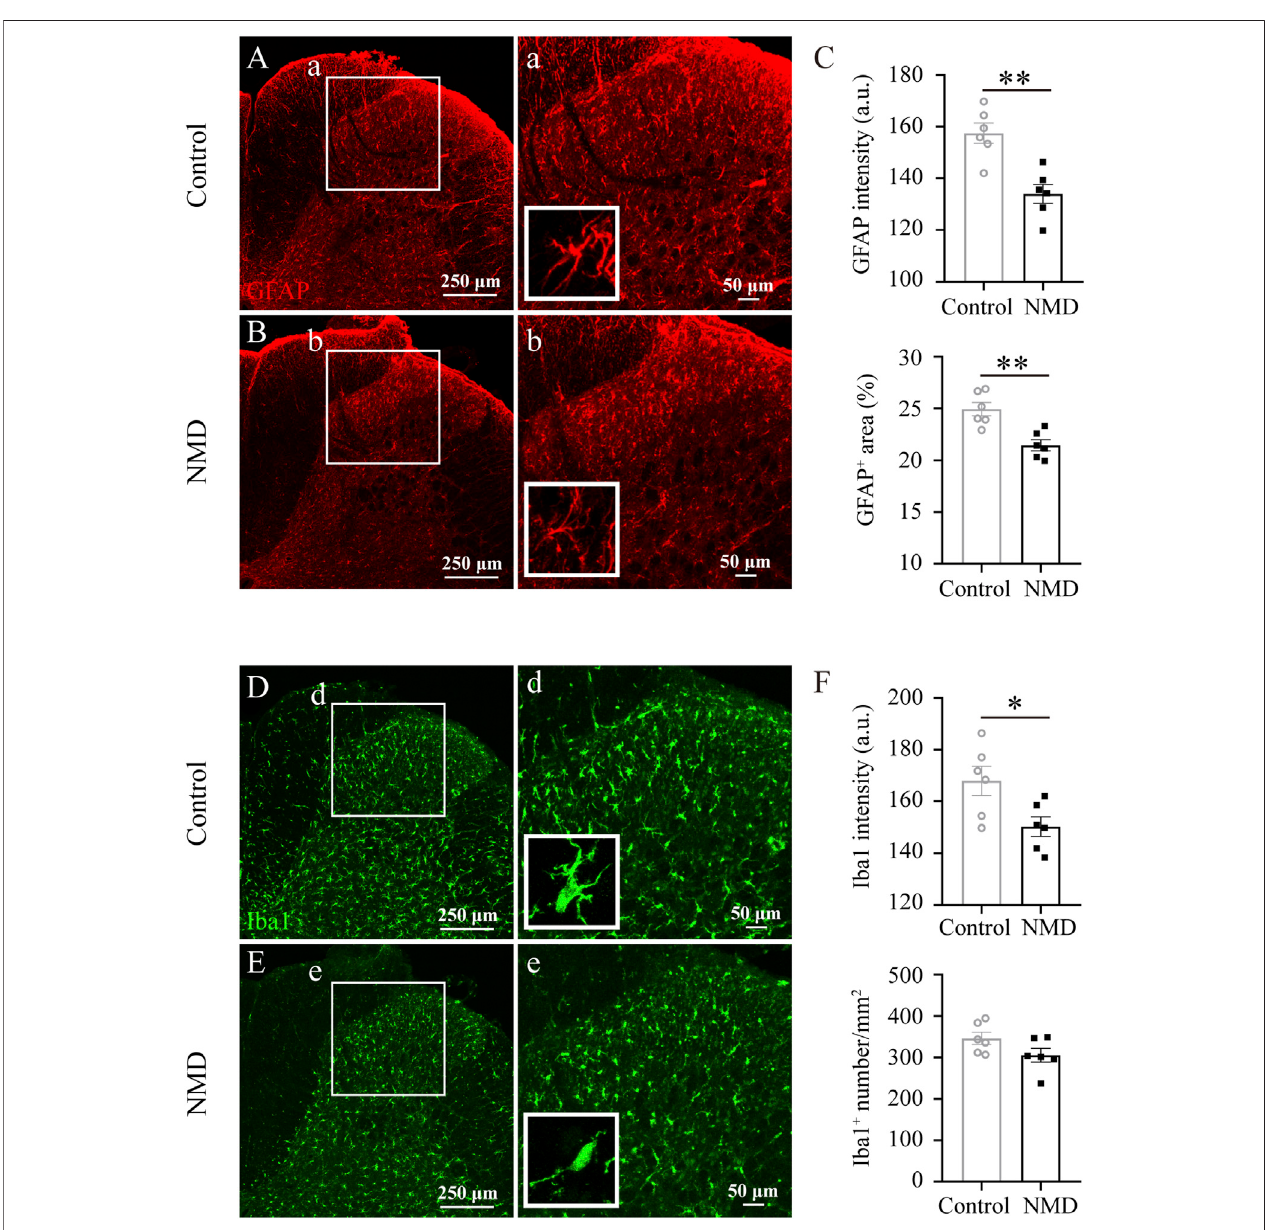
FIGURE5| Long-termadministrationofNMDreducesgliosisinthedorsalhornofthelumbarspinalcord. (A – B) RepresentativeimagesofGFAPimmunostainingin the dorsal horn of the lumbar spinal cord in control and NMD-treated rats. The boxed region in each image is magni fi ed in the corresponding panel a, b. NMD treatment attenuated the increases in the area intensity and hypertrophy (insets) compared with controls. (C) The GFAP intensity and the percentage of GFAP + area were signi fi cantlysmallerintheNMD-treated ratsthaninthecontrols( n (cid:1) 6ratsineachgroup).Unpairedt-test,GFAPintensity,t(10) (cid:1) 4.346, p (cid:1) 0.0015;percentageof GFAP+area,t(10) (cid:1) 4.147, p (cid:1) 0.002.Arbitraryunit,a.u. (D – E) RepresentativeimagesofIba1immunostaininginthedorsalhornofthelumbarspinalcordincontroland NMD-treatedrats.Theboxedregionineachimageismagni fi edinthecorrespondingpaneld,e.NMDtreatmentattenuatedtheincreasedareaintensityandhypertrophy (insets) compared with controls. (F) The Iba1 intensity was signi fi cantly reduced in the NMD-treated rats compared with that in the controls ( n (cid:1) 6 rats in each group). Unpaired t-test, t (10) (cid:1) 2.612, p (cid:1) 0.0259. No signi fi cant difference in the Iba1+ cell numbers was observed between groups.